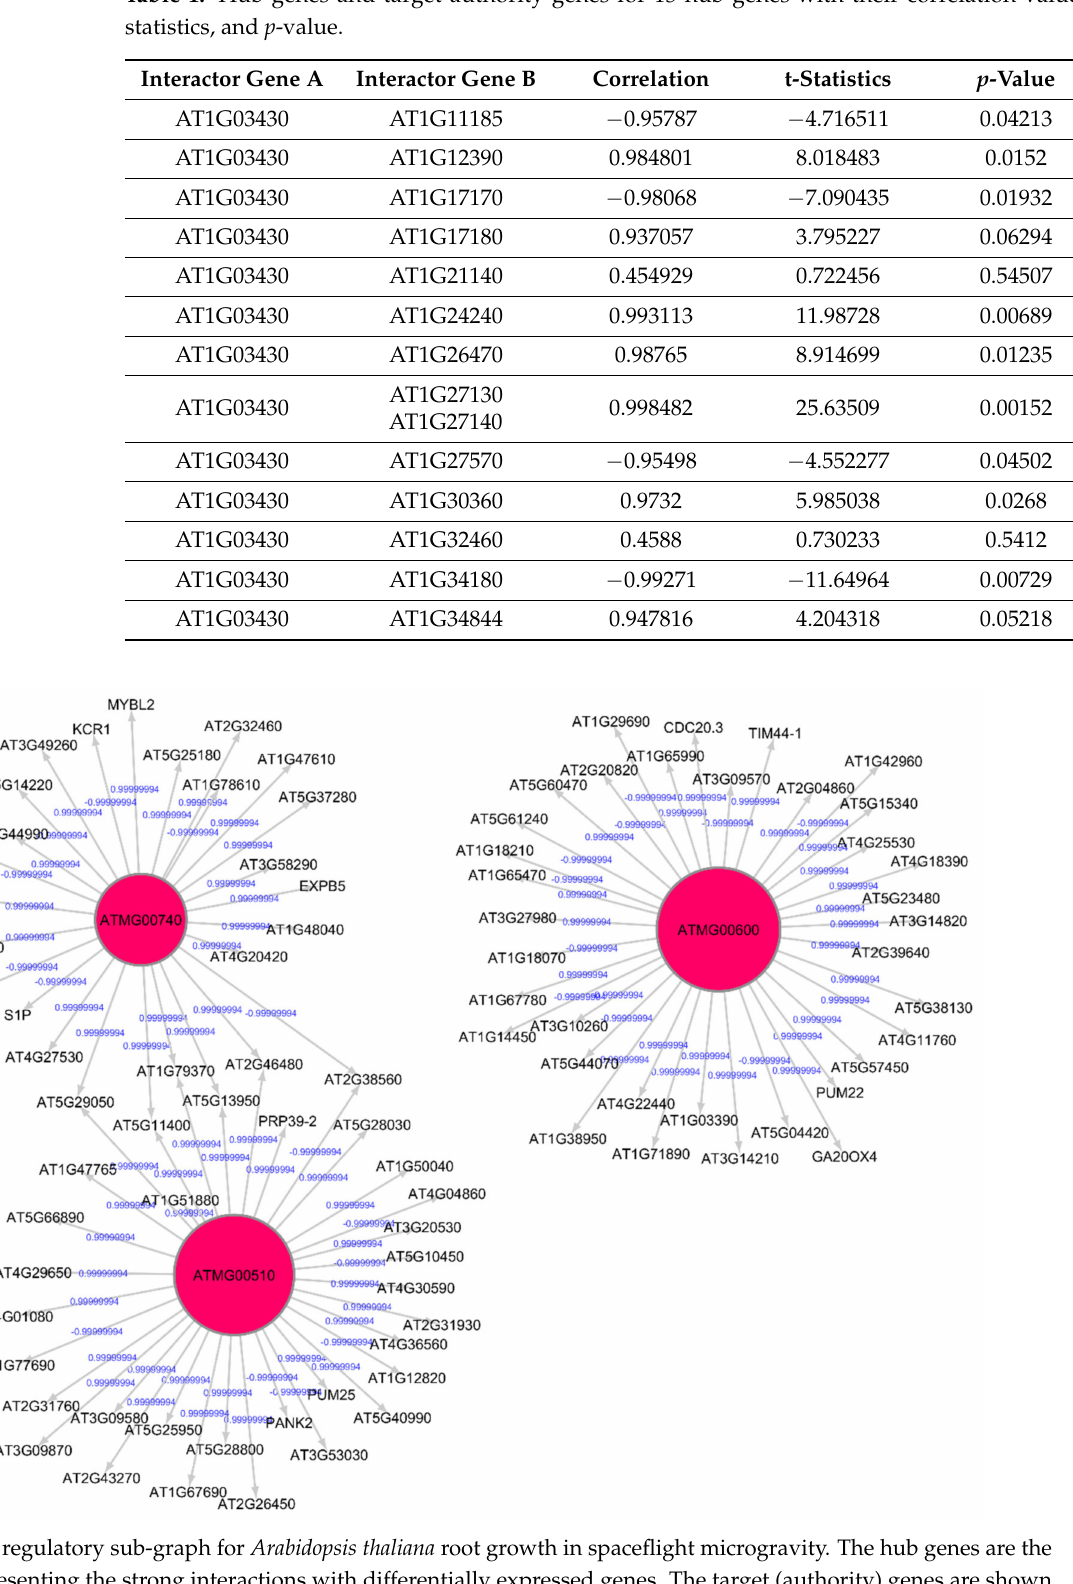
Table 1. Hub genes and target authority genes for 13 hub genes with their correlation value, t-